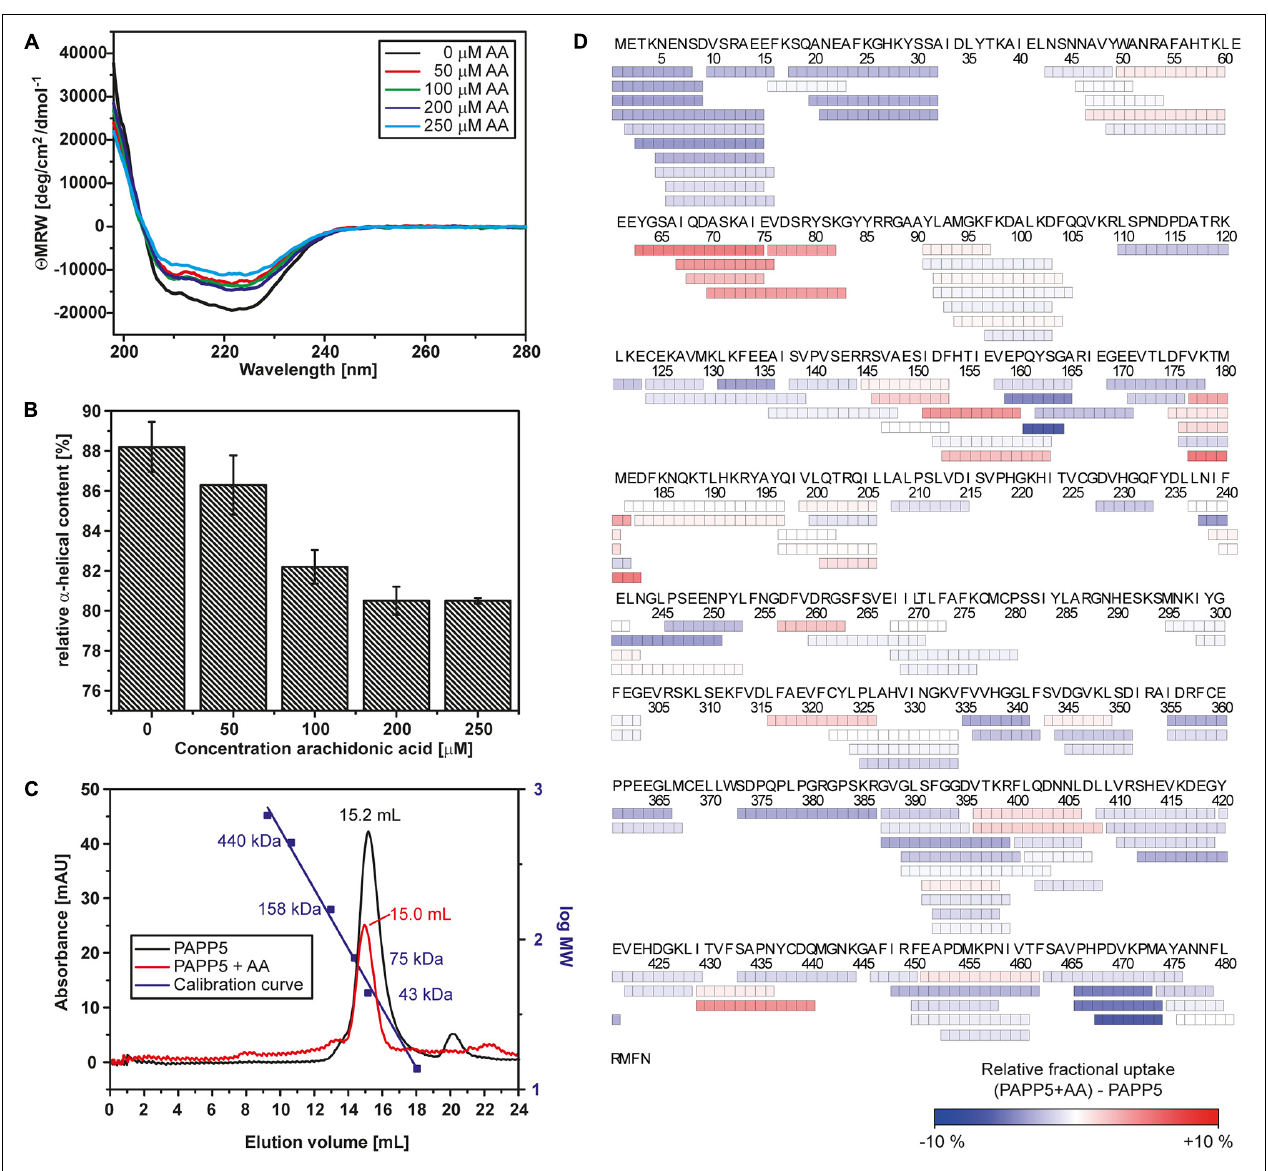
FIGURE 1 | Arachidonic acid activates At PAPP5 by altering its structure. (A) Far-UV CD-spectrum of At PAPP5 in the absence or presence of various concentrations of arachidonic acid (AA). (B) Calculated relative alpha-helical contents from the CD measurements presented in a bar chart. (C) Size exclusion chromatogramm of At PAPP5 in the presence or absence of AA. The addition of arachidonic acid alters the elution volume from 15.18 to 14.96 mL. The molecular masses of calibration standards are plotted using the second logarithmic ordinate. The absorbance was recorded at 280 nm, respectively. (D) Coverage map of the HDX-MS analysis for the difference between At PAPP5 and At PAPP5 with AA after 15 s deuterium incubation. Each box reflects one peptide and the coloring is according to the relative fractional deuterium uptake colored in blue-white-red